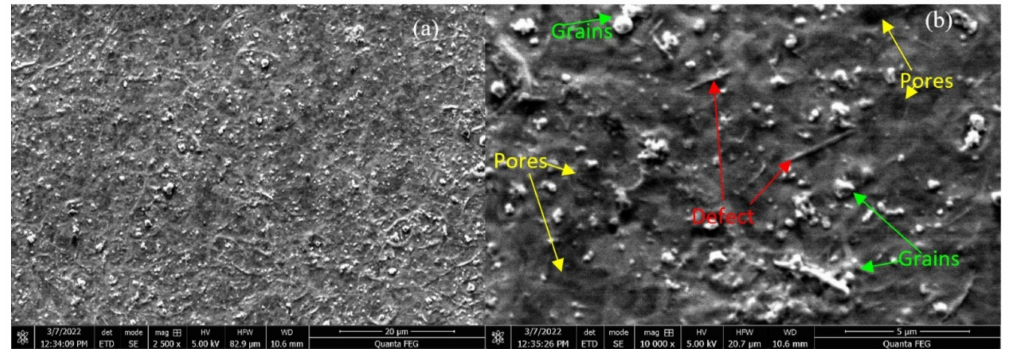
Figure 2. SEM image of the NiO film surfaces: ( a ) across 100 µ m of the sample surface, ( b ) on a small area of the sample covering 20 µ m.